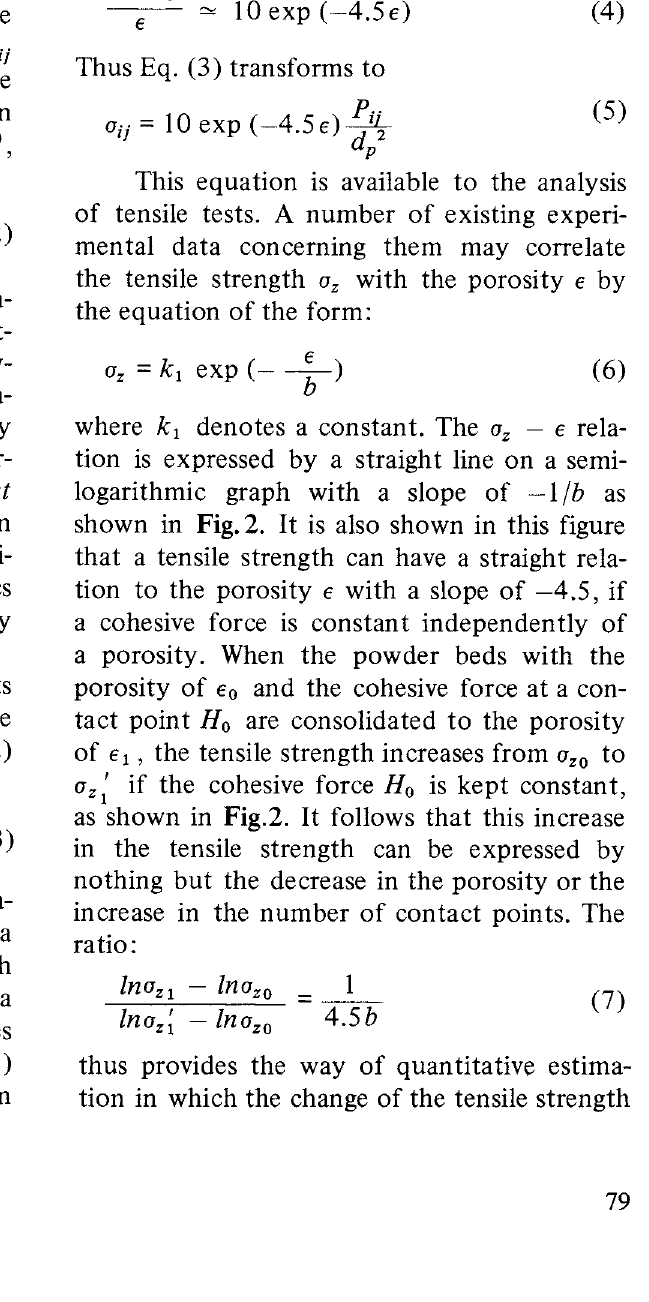
Fig. 2 Relationship between tensile strength a and porosity E with an error of not over 10